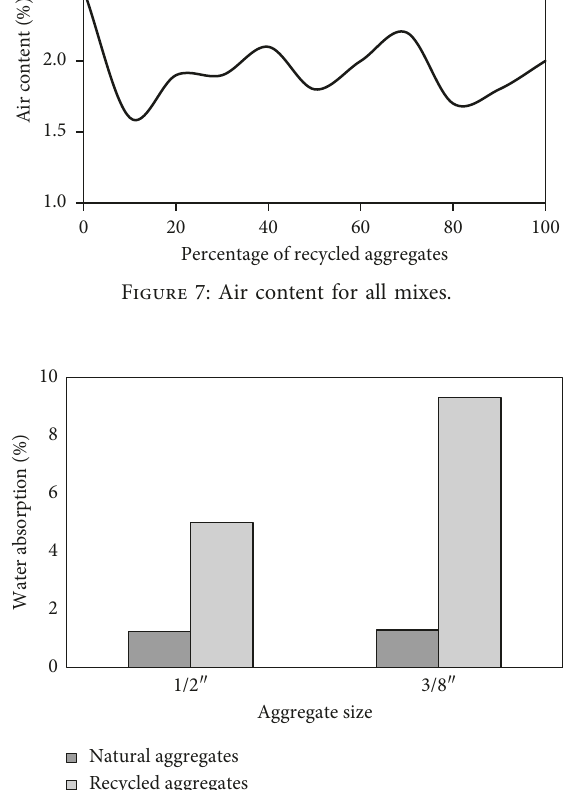
Figure 8: Water absorption of natural and recycled aggregates.